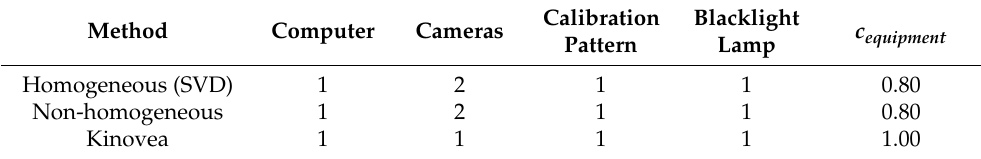
Table 9. Equipment required by each MVS.